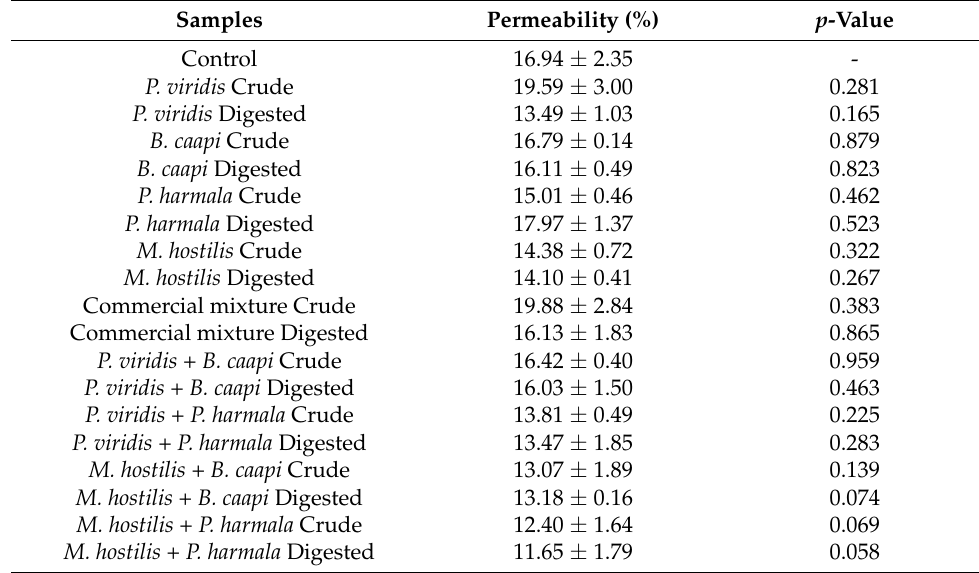
Table 5. Percentage of permeability of Caco-2 cells after incubation with the extracts. The values are expressed as mean ± SD. Statistically significant values were considered if p < 0.05